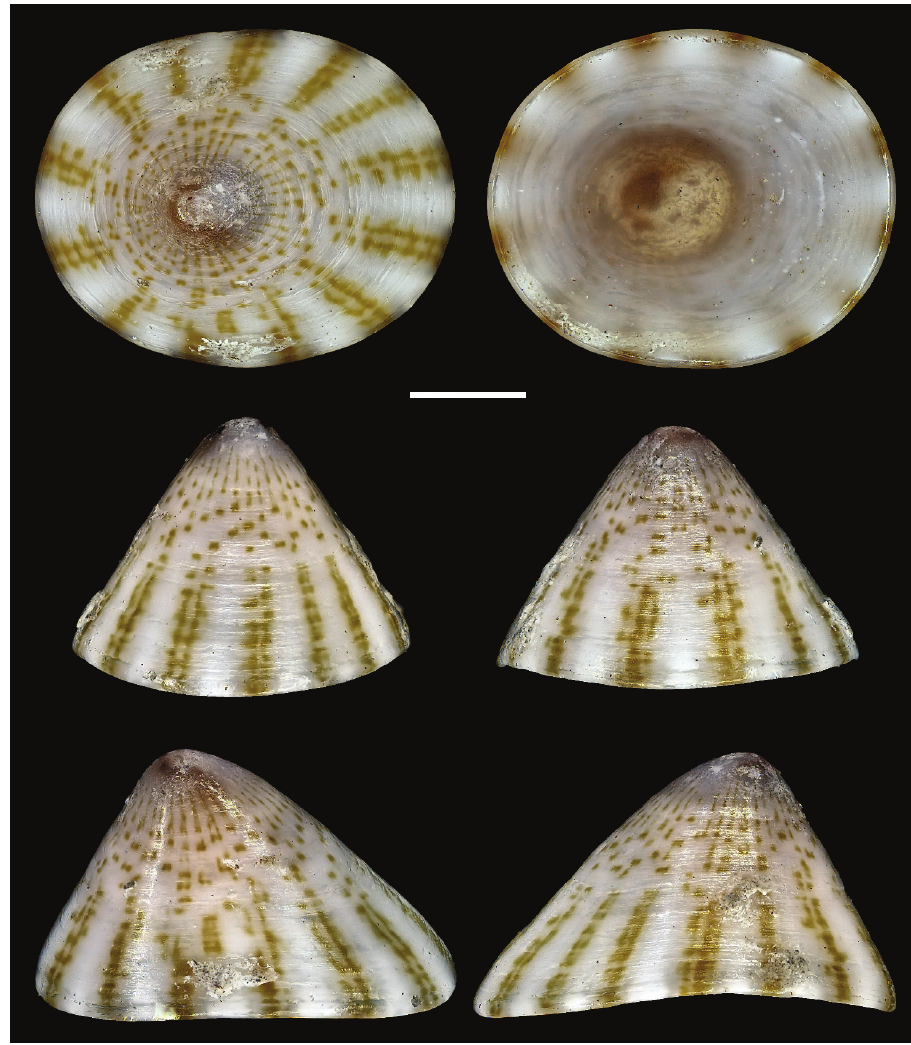
Figure 2. Acmaea ( Tectura ) maraisi Kilburn, 1977. Holotype T2051/NMSA-MOL 0A4585. Scale bar: 1